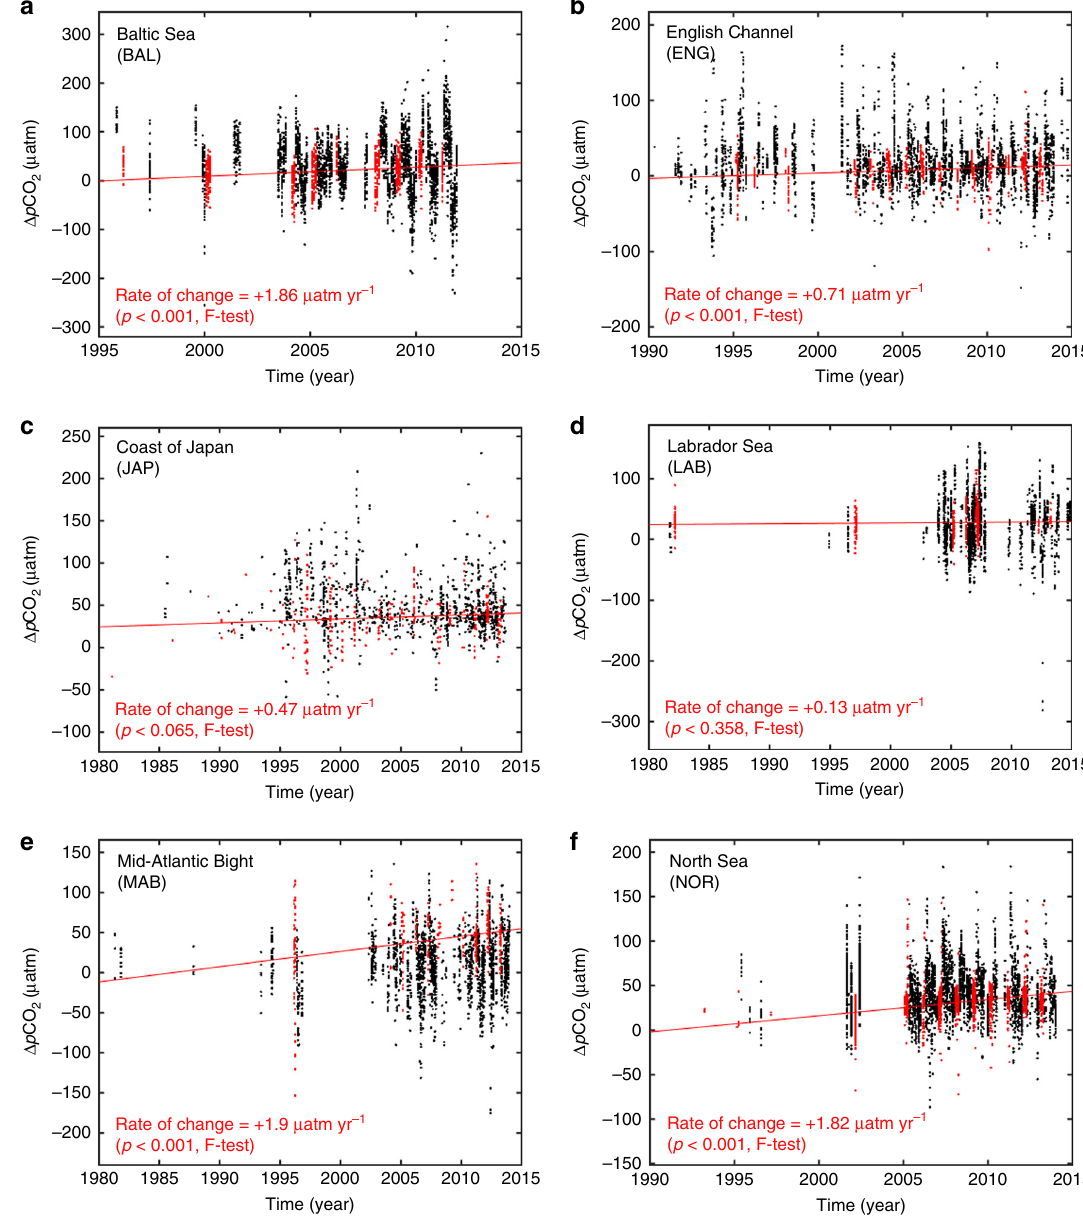
Fig. 3 Δ p CO 2 as a function of time for all cells comprised in the six regions with best data coverage. a Baltic Sea, b English Channel, c Coast of Japan, d Labrador Sea, e Mid-Atlantic Bight, and f North Sea. Red dots correspond to winter data only, black dots to data for all